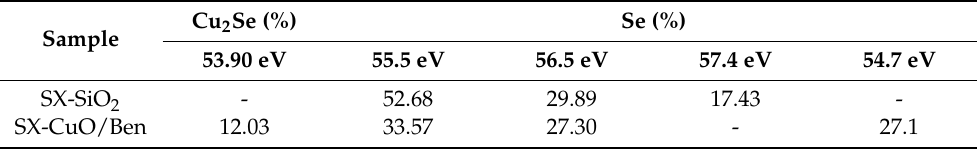
Figure 4. XPS spectra of ( a ) coal ash after conventional gasification and ( b ) reduced CuO/Ben using SX coal after CLG. Table 4. Percentages of Se species determined from XPS